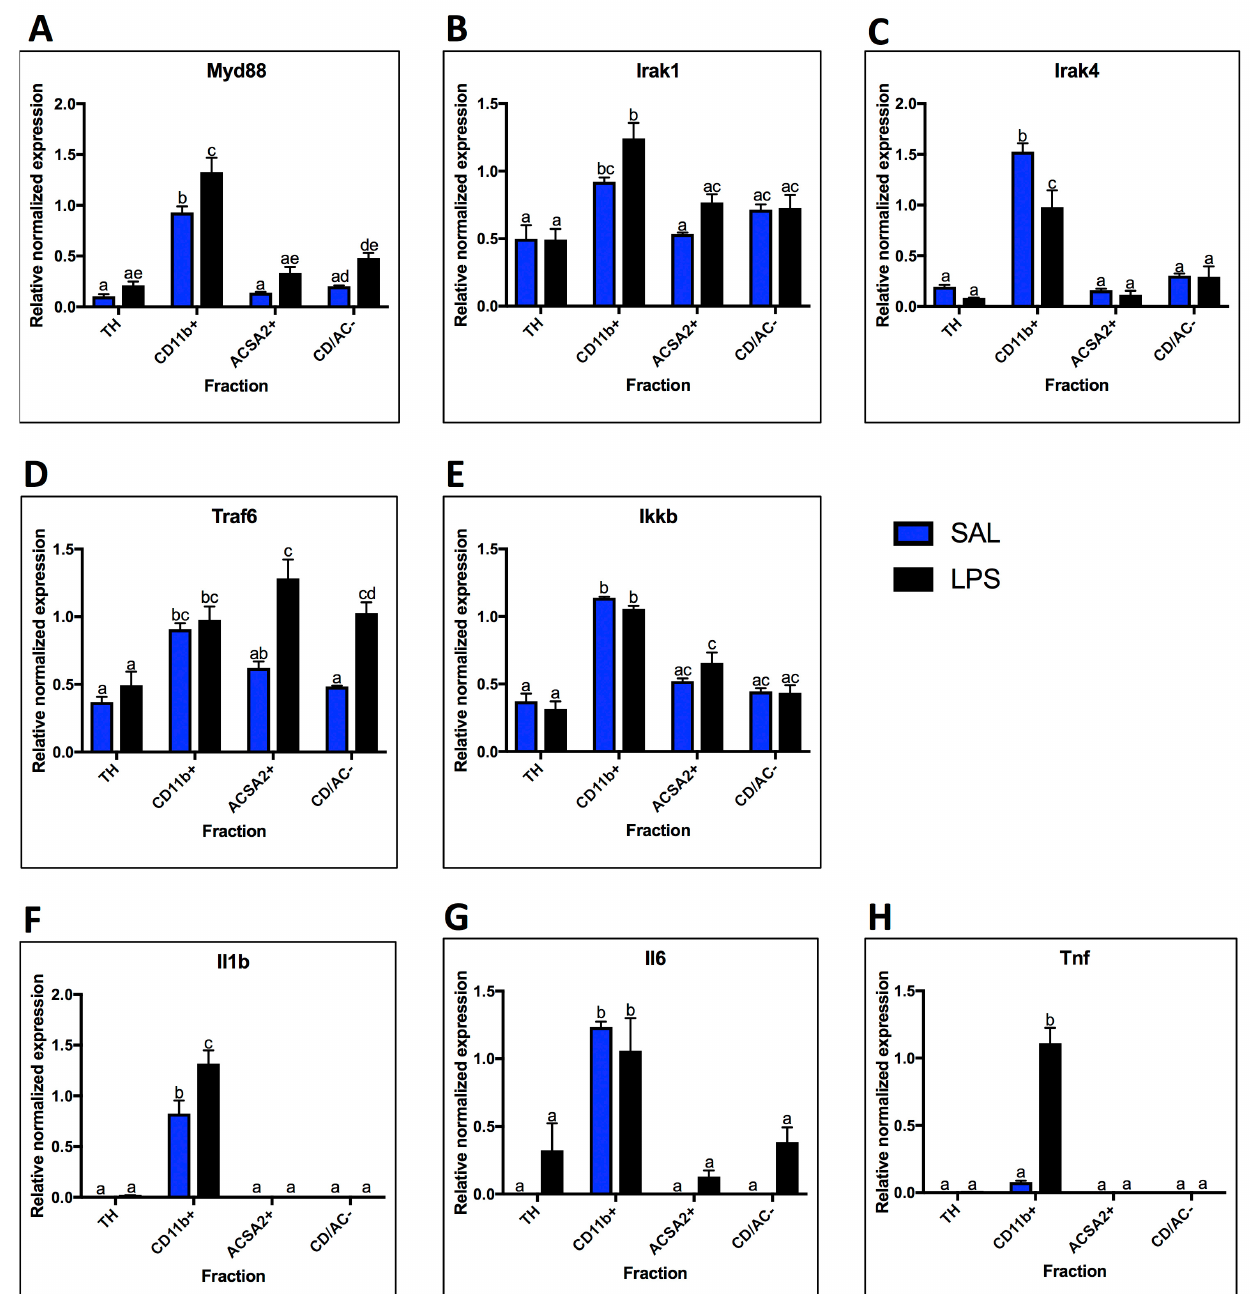
Figure 4. MyD88-dependent pathway mRNA expression. Fraction localization and LPS expression changes for components and outputs of the MyD88-Dependent Pathway, measured by qPCR. A. MyD88 is highest enriched in the microglial fraction and increases with LPS. B. Irak1 is highest enriched in the microglial fraction, but present in moderate levels (expression is 50% or more than that of microglia) in all other fractions. Irak1 expression increases in microglia with LPS. C. Irak4 expression is highly enriched in microglia under basal conditions, and decreases in microglia after LPS. D. With saline, Traf6 is enriched in the microglial fraction, but present in moderate levels in all other fractions. With LPS, Traf6 expression increases in the astrocyte fraction and the negative fraction. E. Ikkb expression was highest in microglia, but expressed in moderate levels in all other fractions. No significant expression changes were seen after LPS treatment. F. Expression of Il1b is only detected in microglia and increases with LPS. G. Expression of Il6 is only detected in microglia with saline, but is detected in all other fractions after LPS. H. Tnf was only detected in the microglial fraction and increased following LPS. Two bars with the same letter are not statistically different; two bars with no letter in common are statistically different (two-way ANOVA with Tukey’s test for multiple comparisons, p<0.05). SAL, saline; LPS, liposaccharide; TH, total